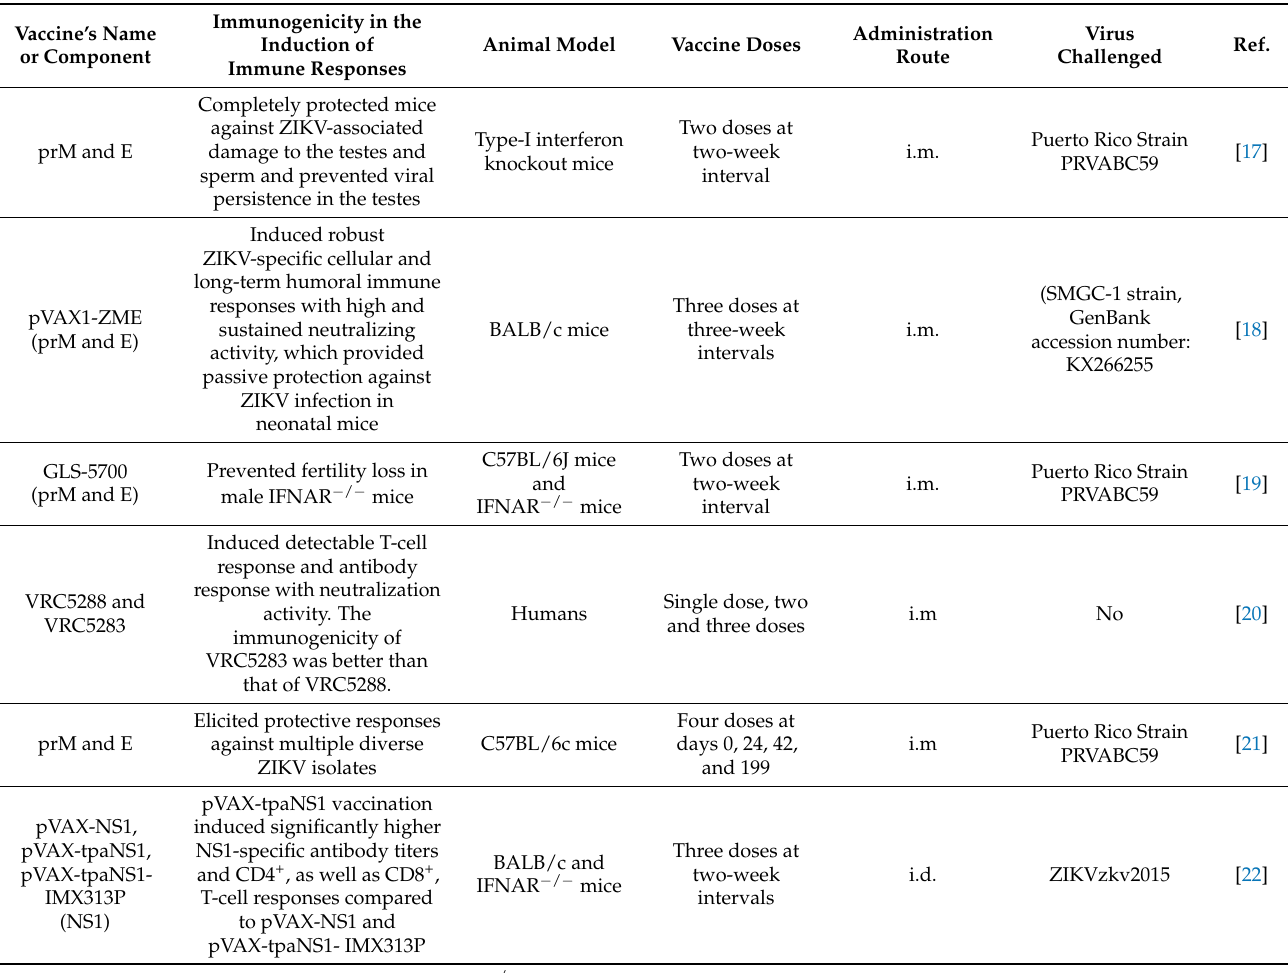
Table 1. DNA vaccines against ZIKV